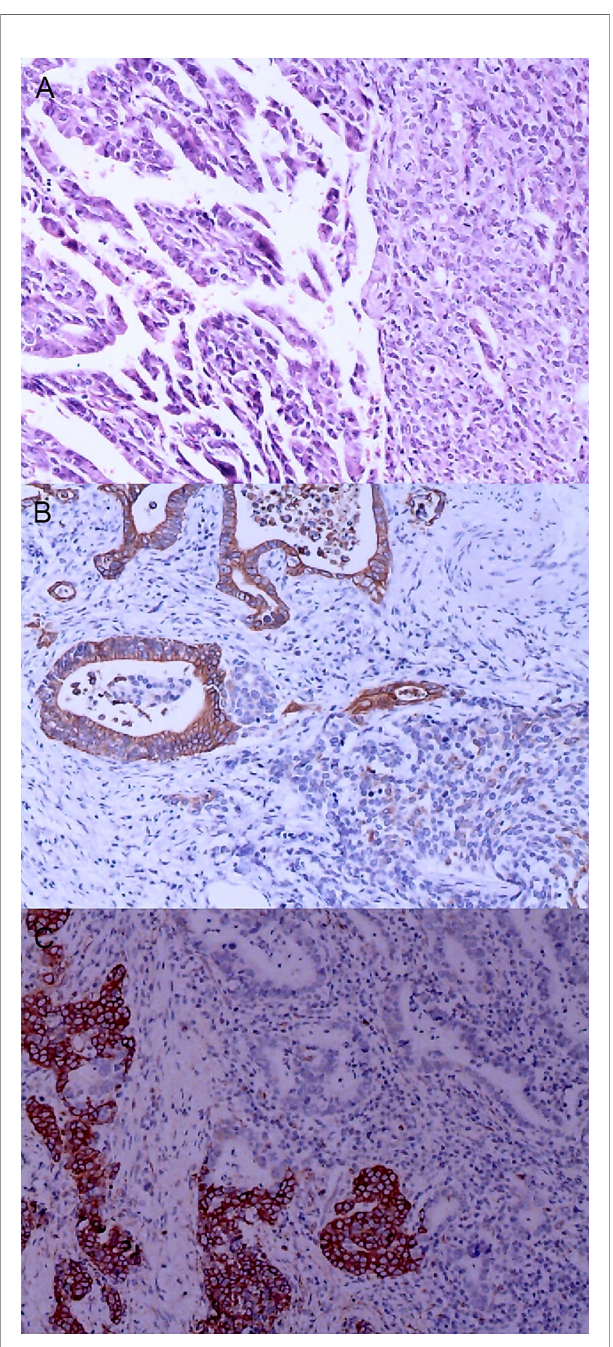
FIGURE 5 | Gastric mixed carcinoma. (A) Gastric mixed papillary adenocarcinoma-neuroendocrine tumor (70% papillary adenocarcinoma/ 30% neuroendocrine tumor, G1), hematoxylin and eosin staining × 40. (B) Positive CgA. CgA was negative in adenocarcinoma components and positive in carcinoid components. En Vision method ×200. (C) CKpan was negative in carcinoid components and positive in adenocarcinoma components. En Vision method × 200.